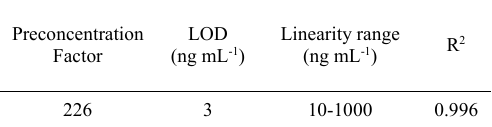
Table 1. Figures of merit for Phenytoin analysis using modified magnetic nanoparticles coupled with HPLC-UV